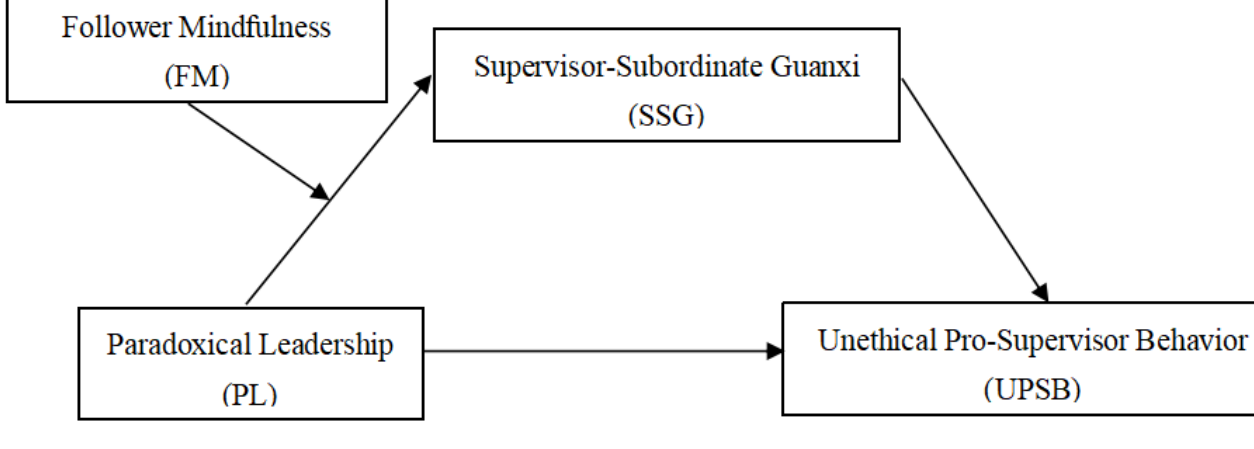
Figure 1. Theoretical framework.